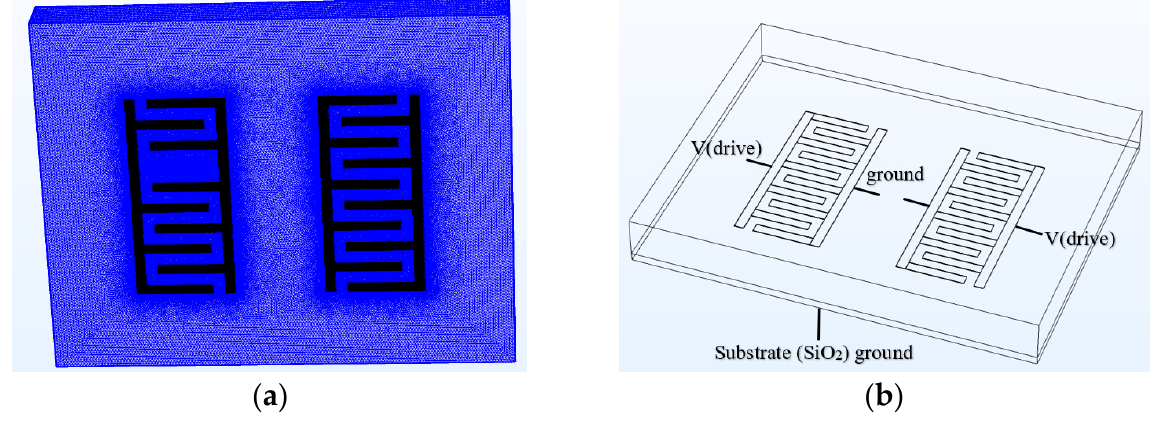
Figure 4. ( a , b ) Boundary conditions and meshing structure of the simulated sensor in COMSOL software.